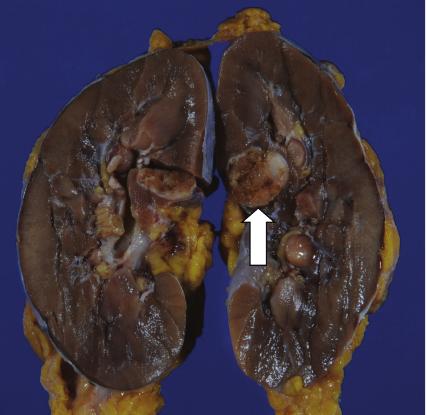
Figure 4: Electron micrograph of a tumor cell. Rhomboidal crys- talline bodies are observed in the cytoplasm of a tumor cell